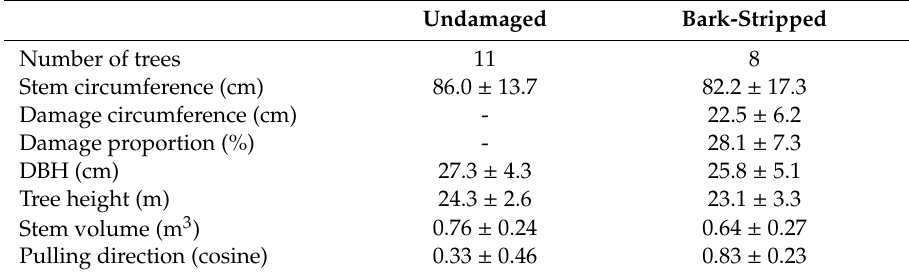
Table 1. Statistics of the studied dataset. Mean values ± 95% confidence intervals are shown.